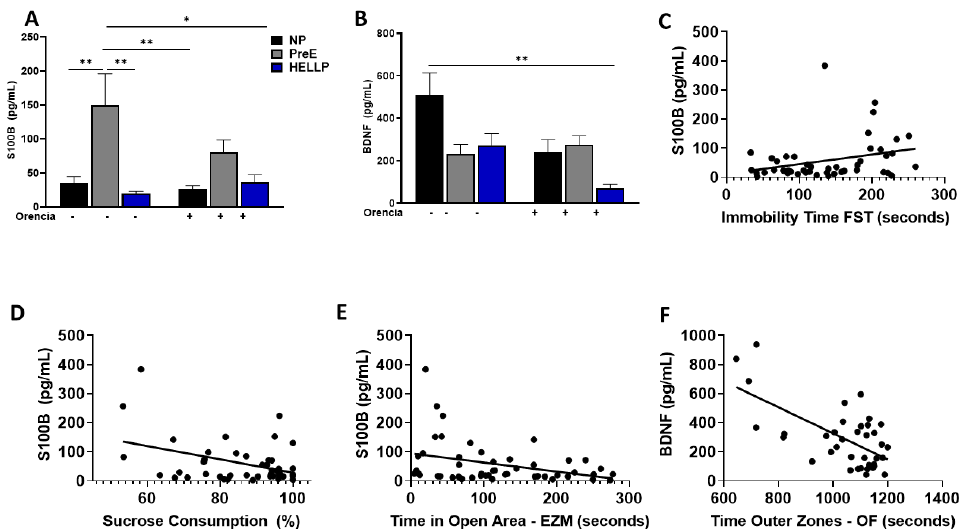
Figure 5. Circulating levels of S100B and BDNF are altered in response to HDP. PreE rats had increased levels of S100B ( A ), and HDP rats had decreased levels of circulating BDNF ( B ) compared to NP rats.